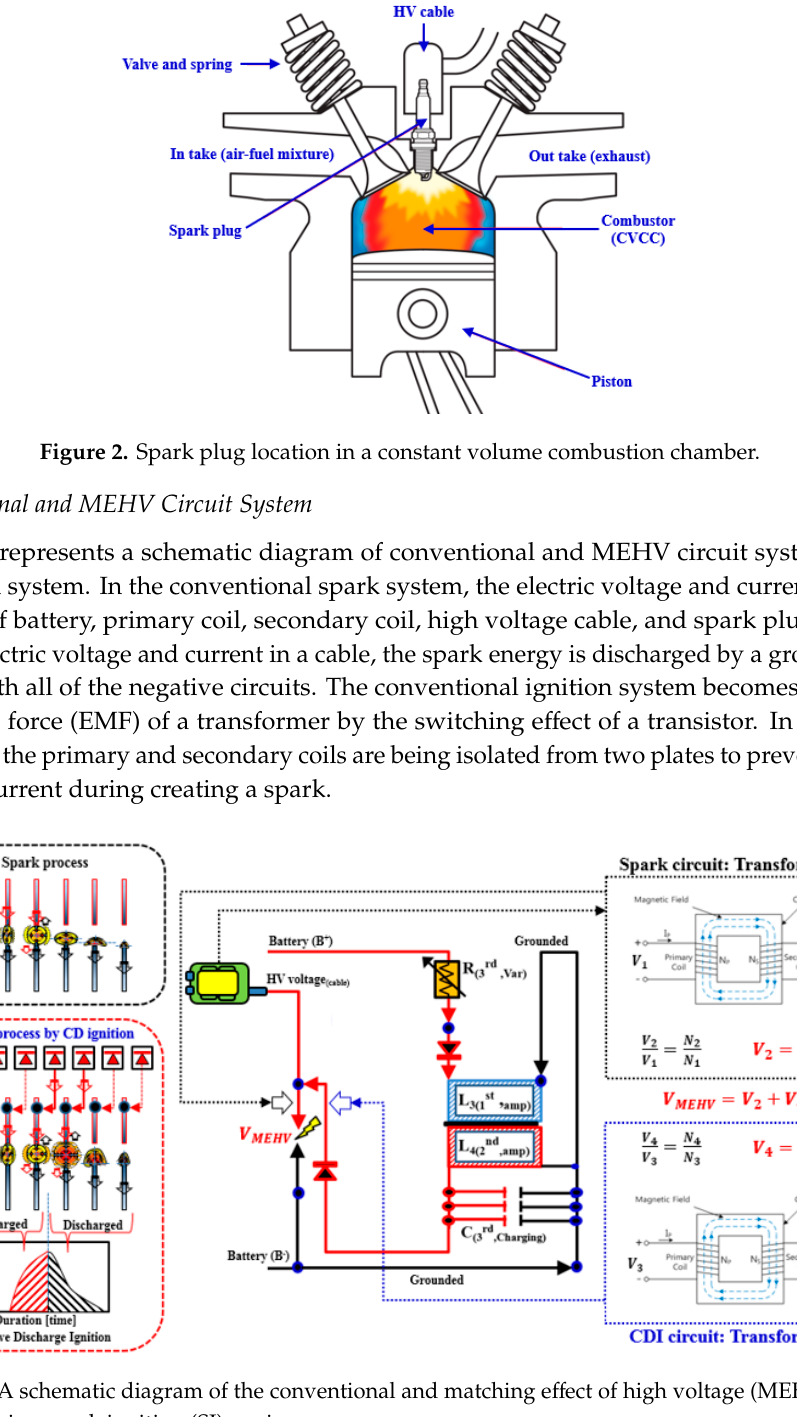
Figure 3. A schematic diagram of the conventional and matching effect of high voltage (MEHV) circuit systems using spark ignition (SI) engines.